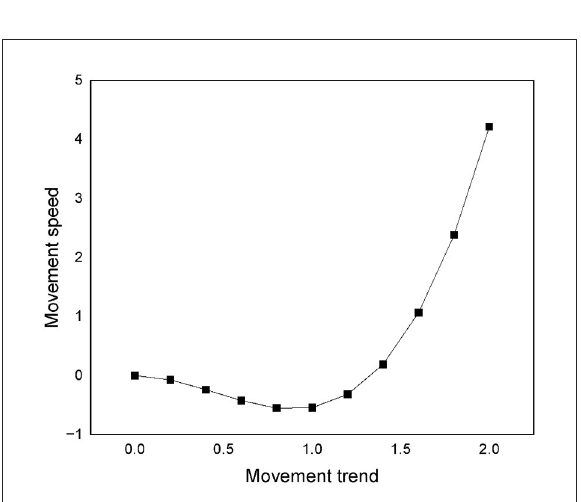
FIGURE4 The potential function simulation of financial